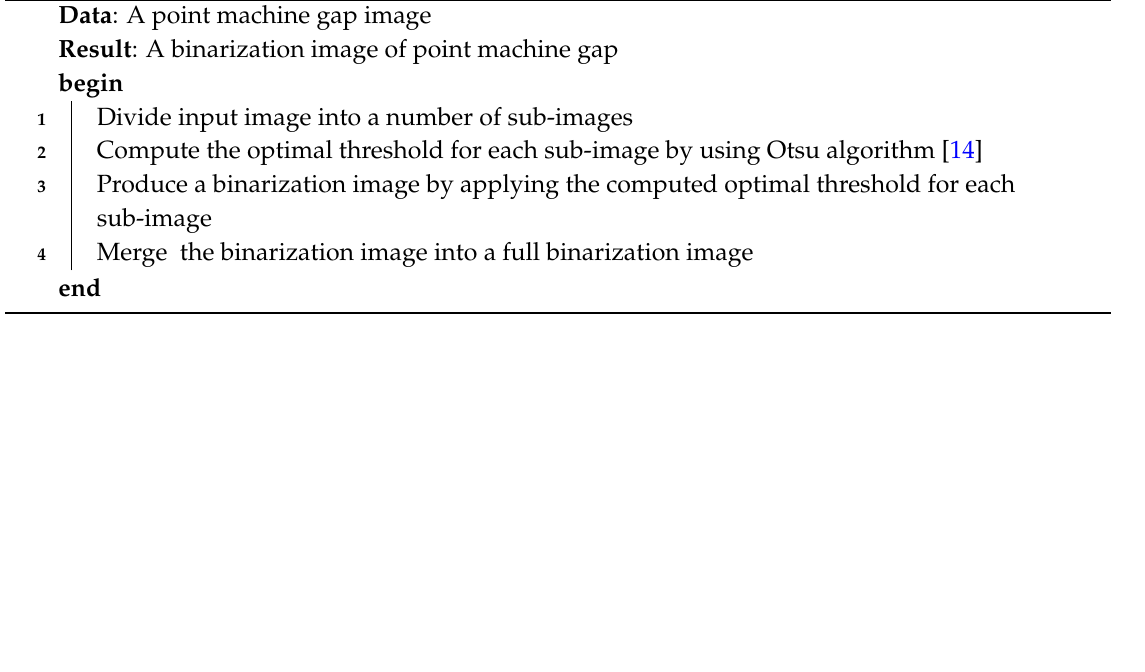
Algorithm 1: Adaptive local image binarization